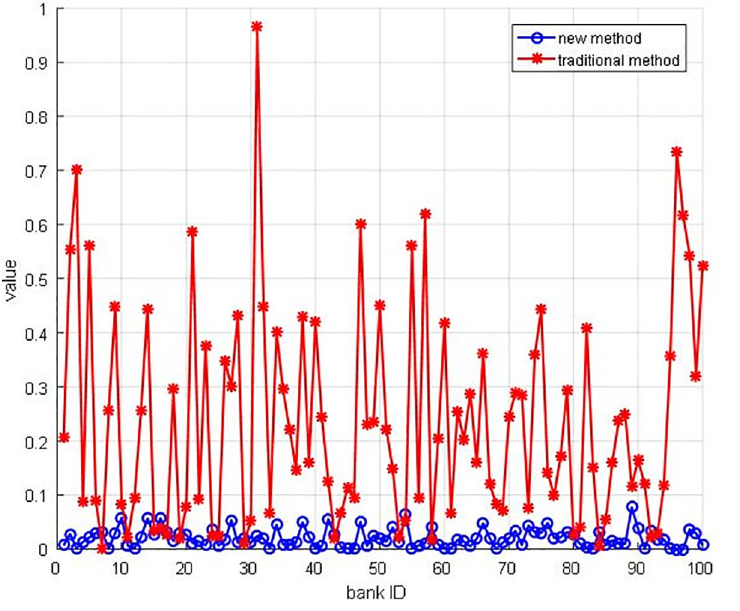
Fig 15. The gap of normalization value.